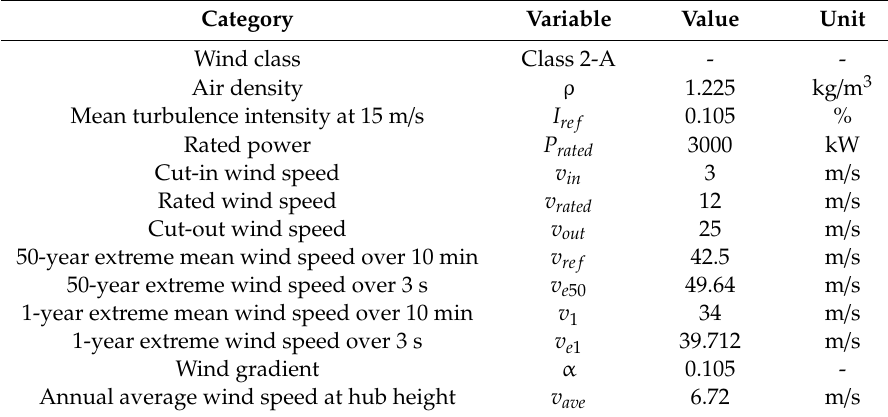
Figure 17. Analysis model and mode shape of the wind turbine system in GH Bladed. Table 5. Design load case